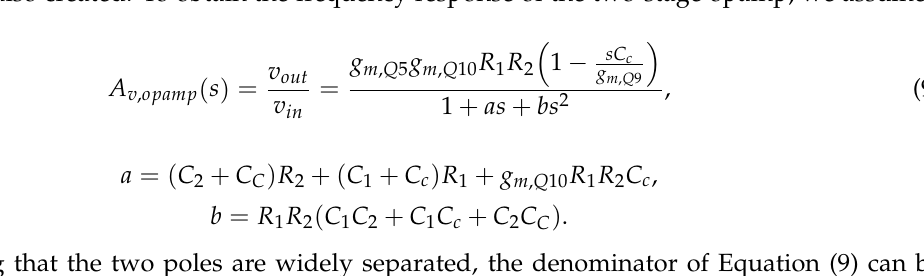
Figure 7. Pole splitting phenomenon due to Miller compensation.